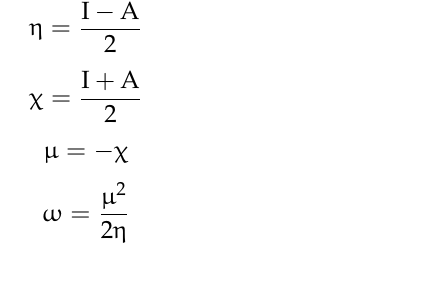
Table 1. The surface coverage and corrosion inhibition efficiency of different Q-22 inhibitor concen- trations for C-steel in 5 M HCl at 25 °C.